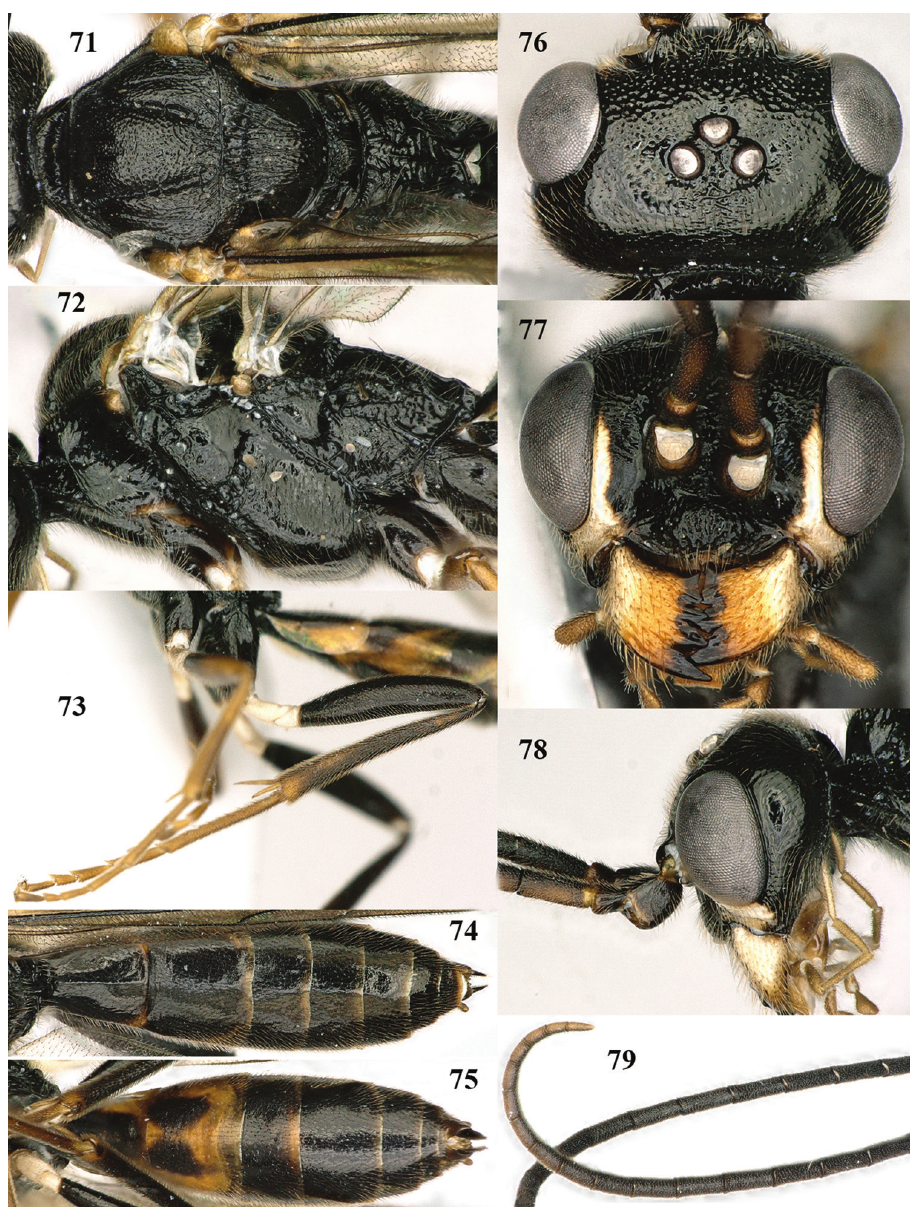
Figures 71–79. Orthogonalys paraclypeata Tan & van Achterberg, sp. n., male, paratype. 71 mesosoma dorsal 72 mesosoma lateral 73 hind leg lateral 74 metasoma dorsal 75 metasoma ventral 76 head dorsal 77 head anterior 78 head lateral 79 apical two-thirds of antenna